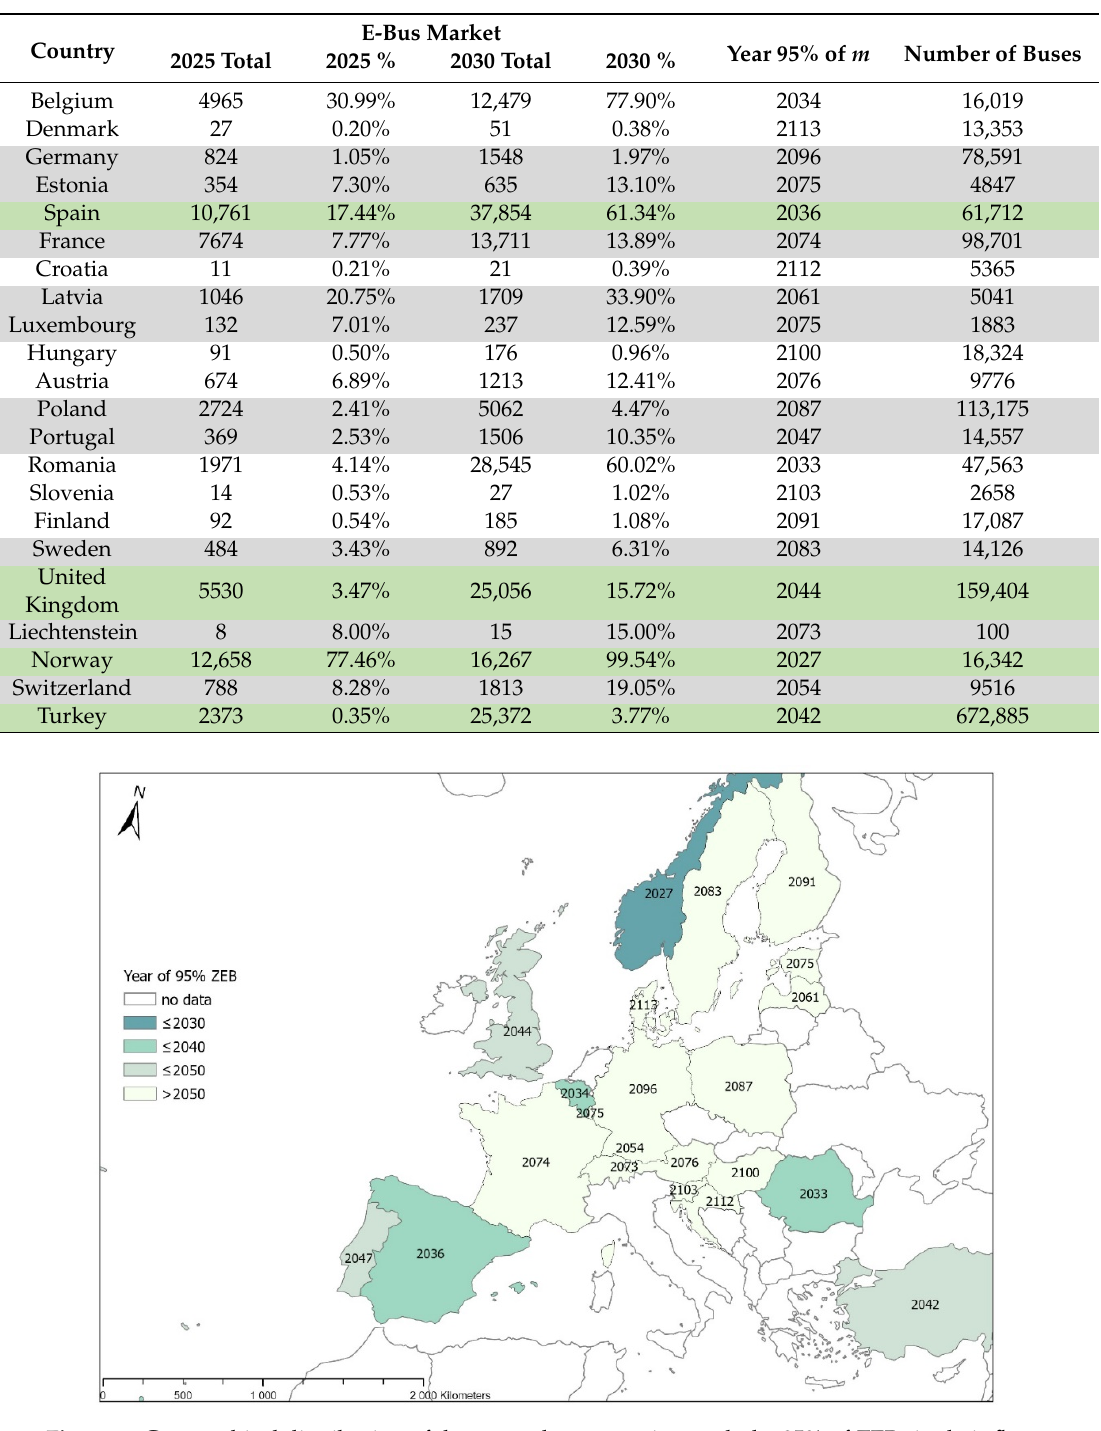
Table 5. Development forecast for the electricity, hybrid diesel-electric, plug-in hybrid diesel-electric, and hydrogen and fuel cells bus market [own study based on data retrieved from Eurostat].